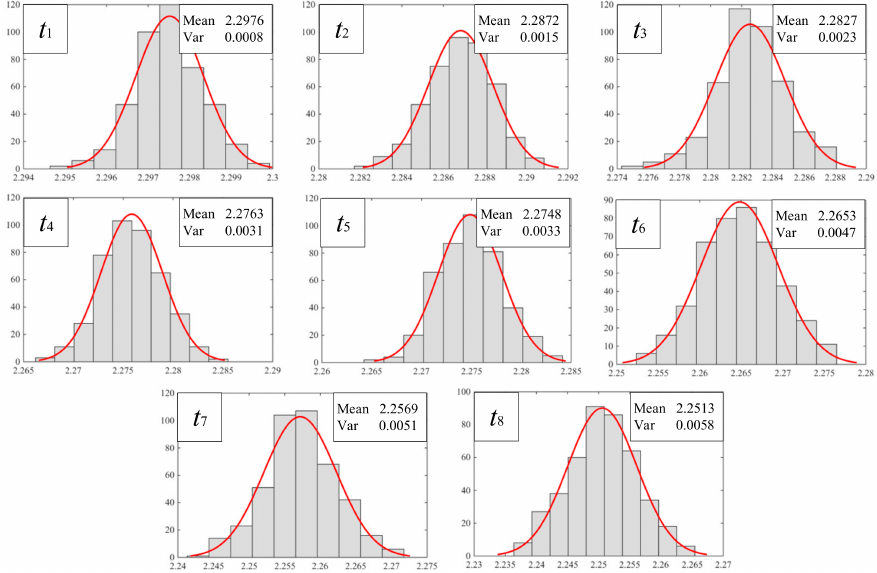
Figure A2. The distribution of thickness at different time under 3